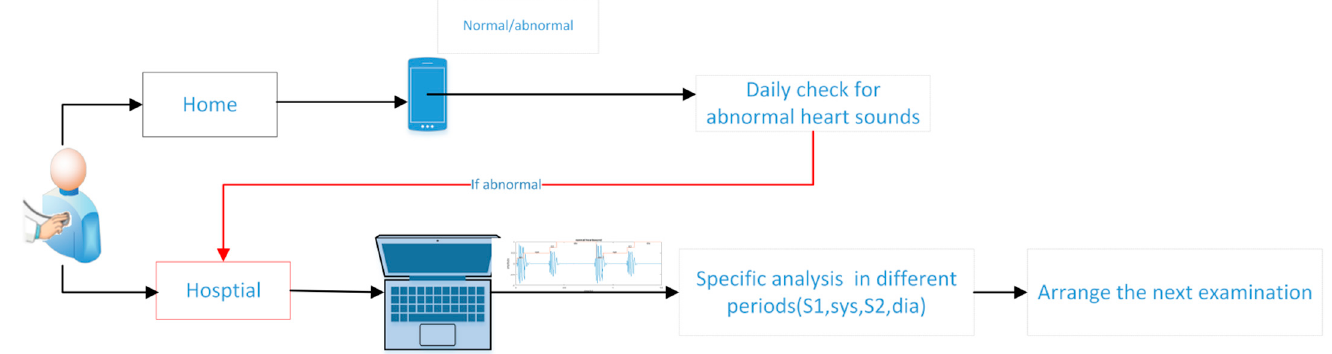
Figure 2. The diagram of auxiliary diagnosis system: preliminary screening and professional diagnosis.